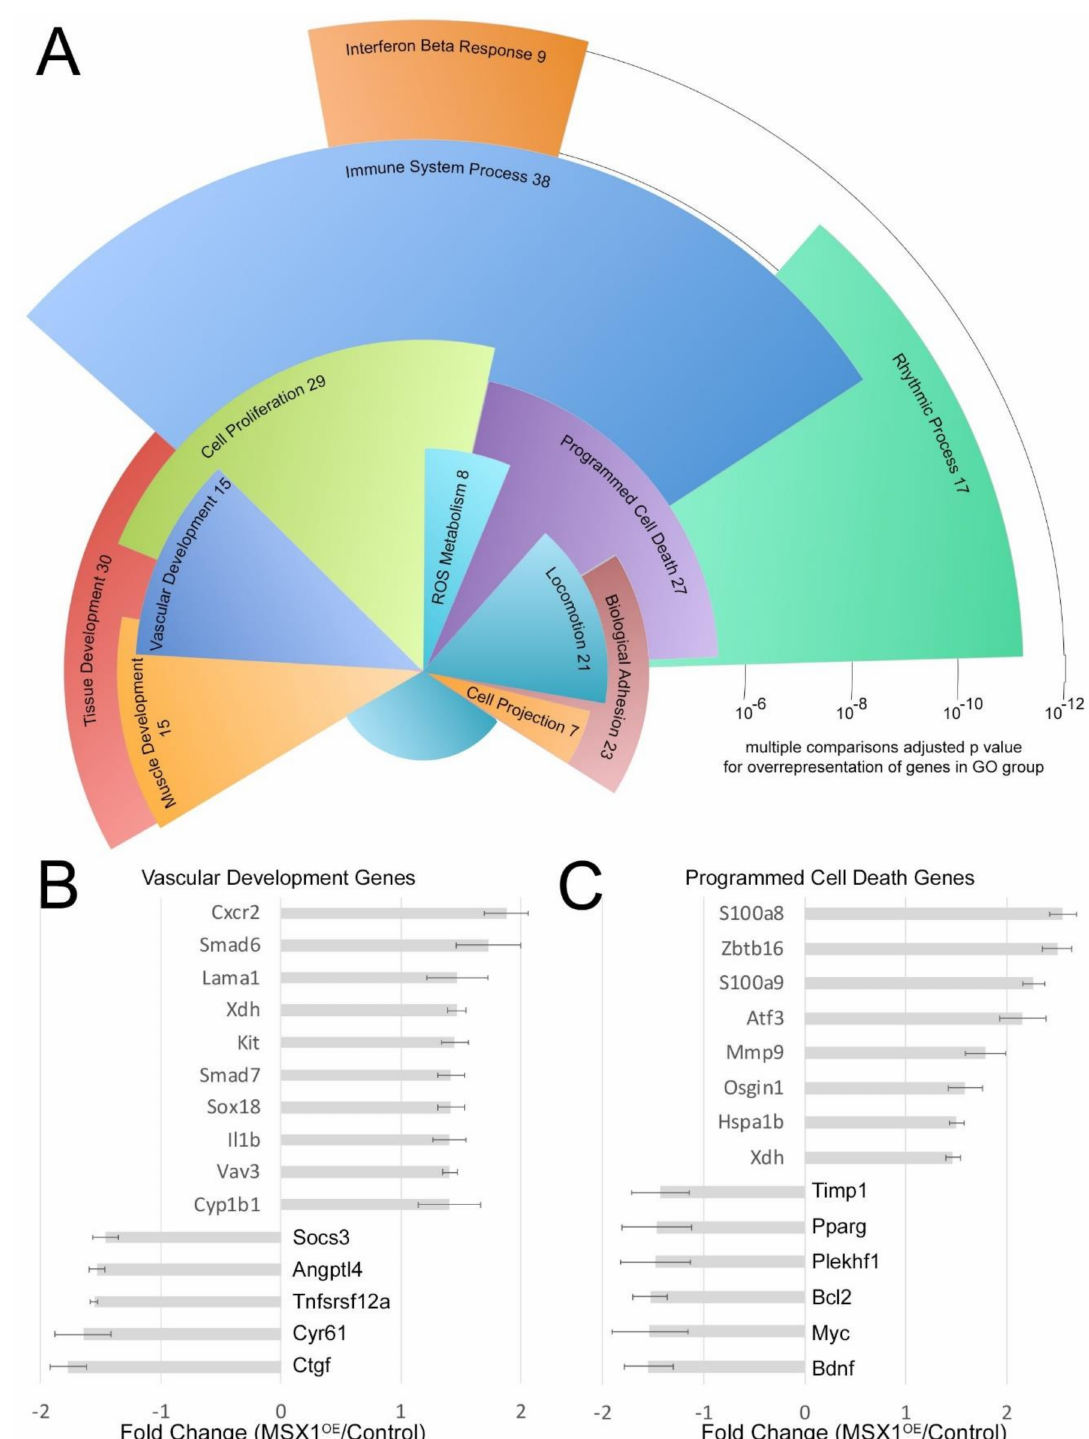
Figure 5. ( A ) Expression arrays comparing Msx1OE mouse lung with controls. ( A ) Overrepresented gene ontology groups from 171 genes with 2-fold changed expression (up or down) in the MSX1 OE mouse compared to controls. Radius corresponds to statistical significance; angular width corresponds to number of genes included. ( B ) Relative expression of genes in the vascular development group. ( C ) Relative expression of genes in the autophagy